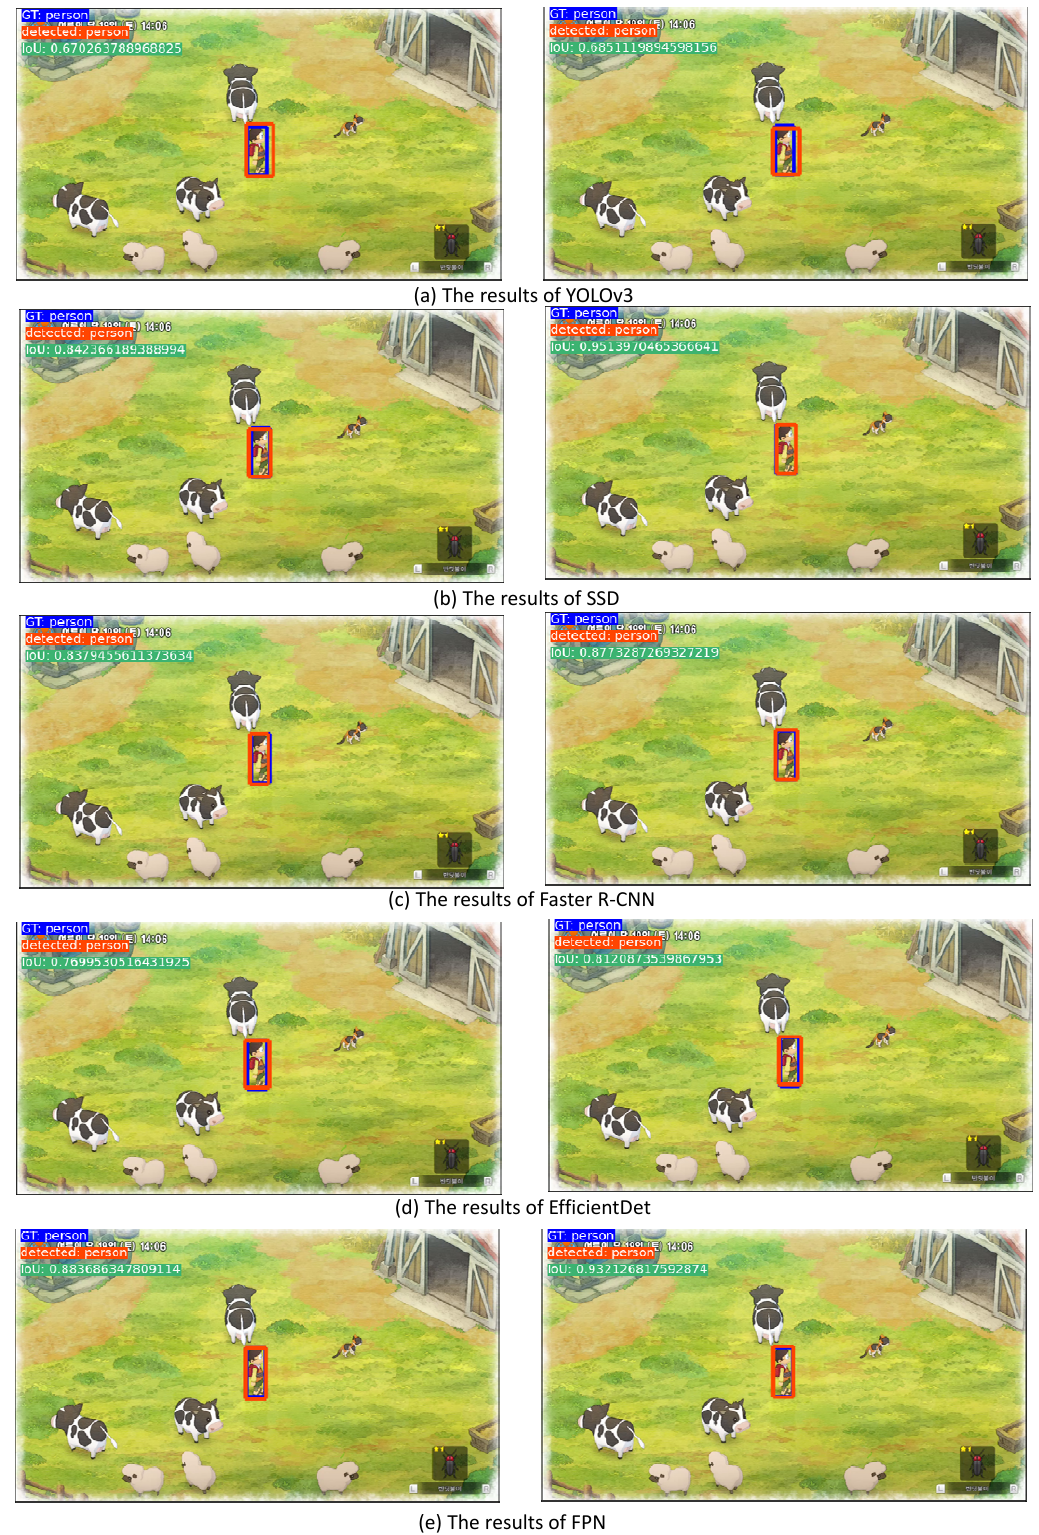
Figure A6. Comparison of the bounding box detection on game Doraemon . The left column is the result from the models trained by PASCAL VOC and the right column is the result from the models trained by PASCAL VOC and game